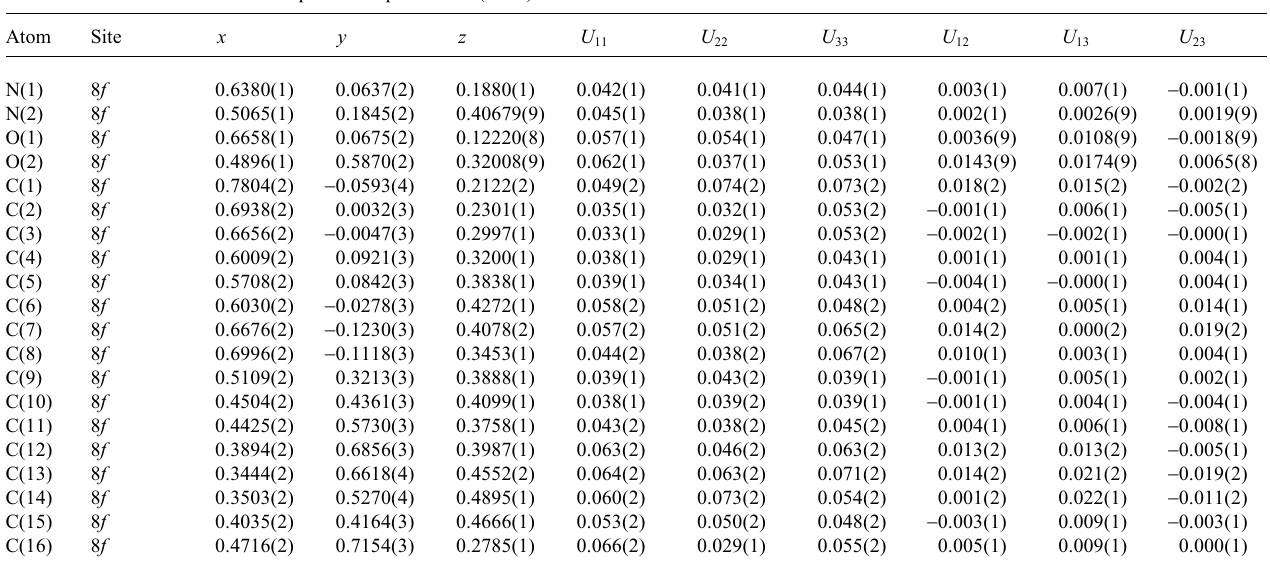
Table 3. Atomic coordinates and displacement parameters (in Å 2 ).